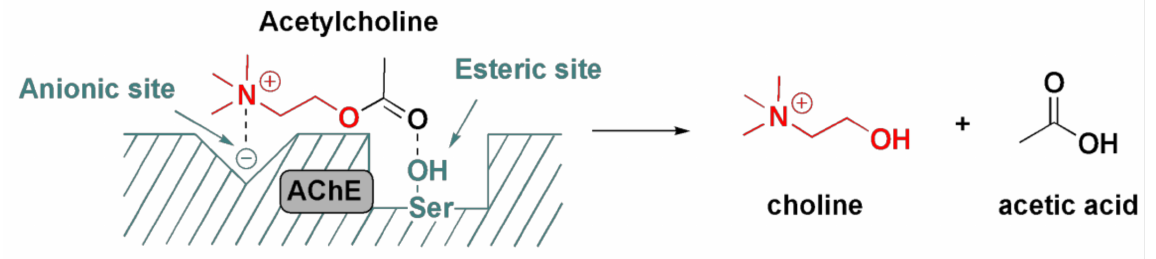
Figure 6. Mechanism of action: role of the acetylcholinesterase (AChE) enzyme in the hydrolysis of